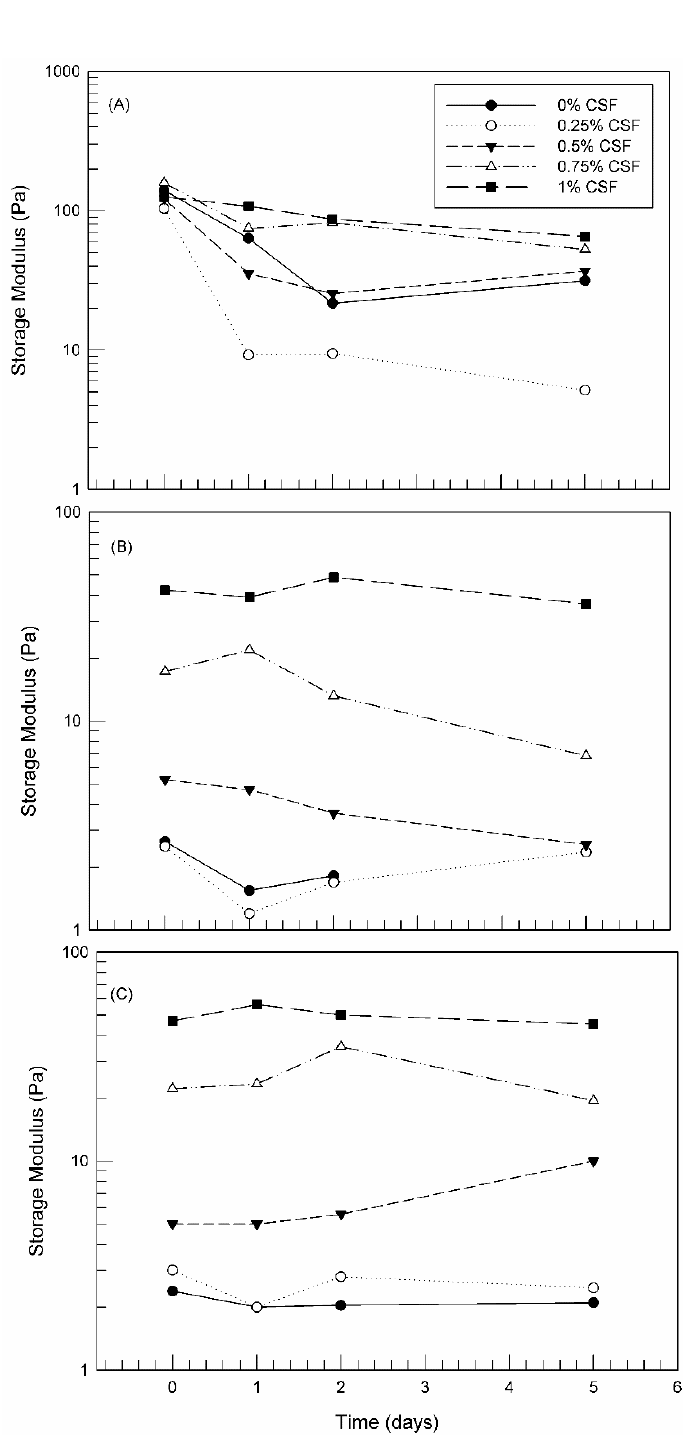
Figure 5. Changes in the storage modulus of yogurt-like structure samples composed by soy milk ( A ), almond milk ( B ) and coconut milk ( C ) (at frequency of 10 Hz) with storage time. The illustrated results were representative of three independent experiments.